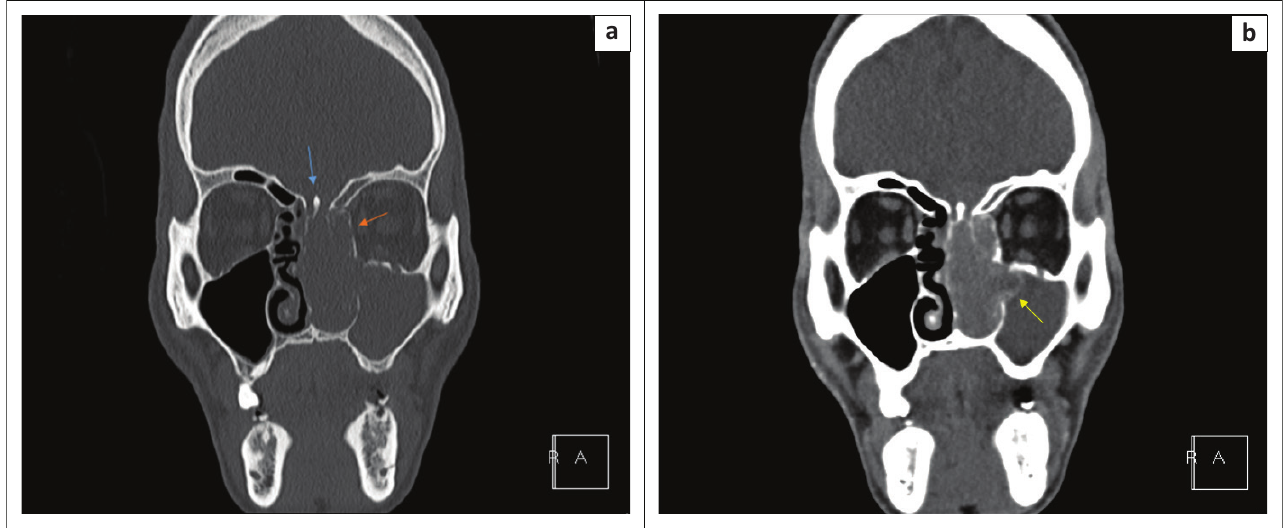
FIGURE 1: (a) Coronal CT bone window shows an expansile, polypoid mass in the left nasal cavity. Superiorly, the cribriform plate, olfactory recess and fovea ethmoidalis are eroded and widened (blue arrow). The nasal septum is deviated to the right. The left anterior ethmoid and frontal sinus air cells are opacified. There is convex bulging of the lamina papyracea, which is eroded (orange arrow). The infundibulum and middle meatus are eroded and widened. The left maxillary is opacified. The hard palate is eroded. (b) Coronal CT soft tissue contrast-enhanced image shows a uniformly contrast-enhancing polypoid tumour in the left nasal cavity, extending to the cribriform plate, olfactory recess and ethmoid sinus. No demonstrable intracranial extension. The left maxillary sinus outflow tract is widened and obstructed by a tumour extending into the infundibulum and middle meatus with a resultant effusion (yellow